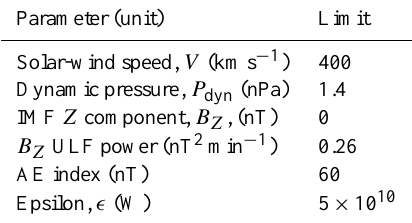
Table 1. Solar-wind parameters and their limit